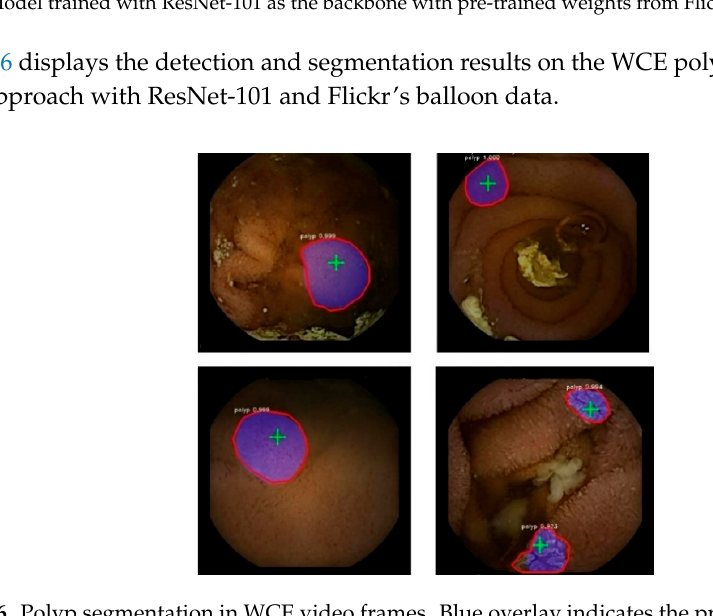
Figure 6. Polyp segmentation in WCE video frames. Blue overlay indicates the predicted segmentation mask. The contour of the ground truth masks is shown in red. Detection points are masked in green.